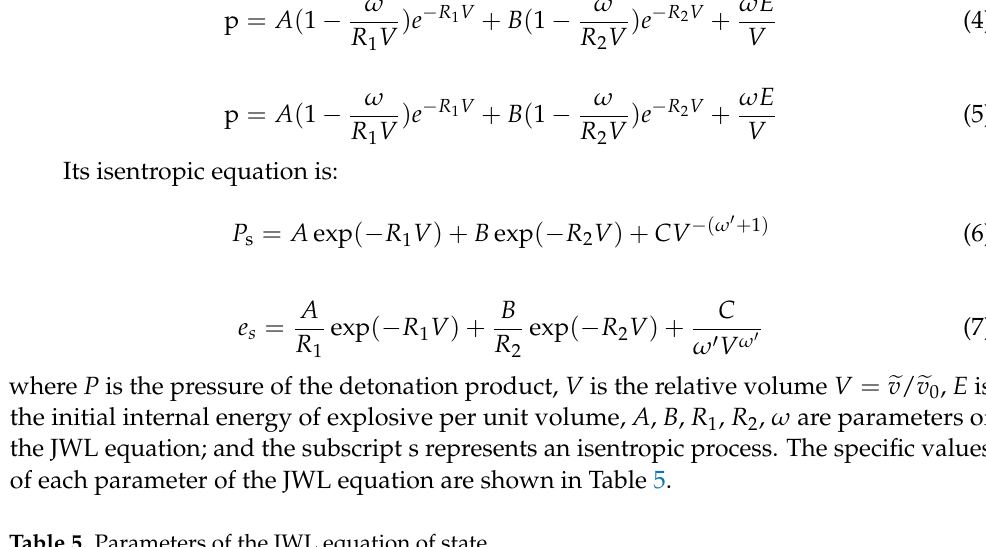
Table 5. Parameters of the JWL equation of